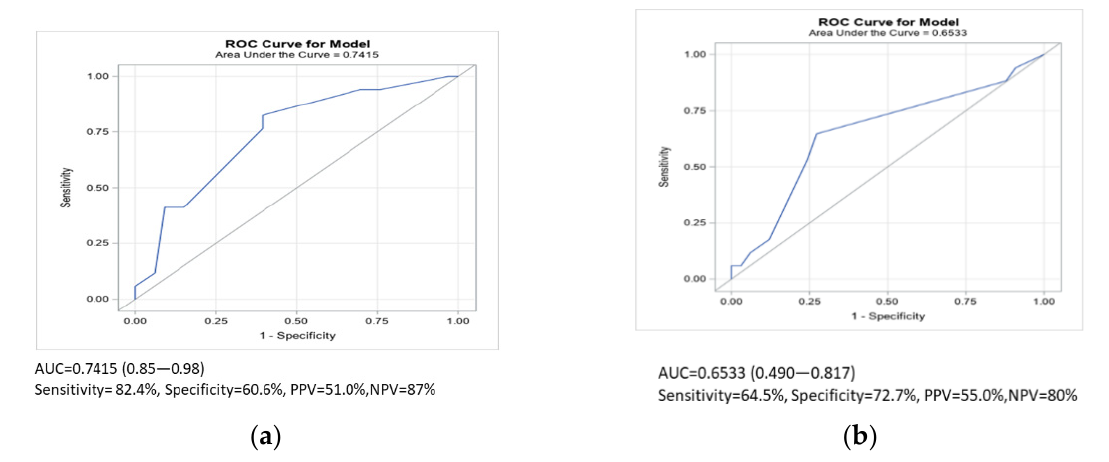
Figure 3. Predictive values of the Wells score and the revised Geneva score: ( a ) ROC curve scale modified Geneva and ( b ) ROC curve scale Wells.